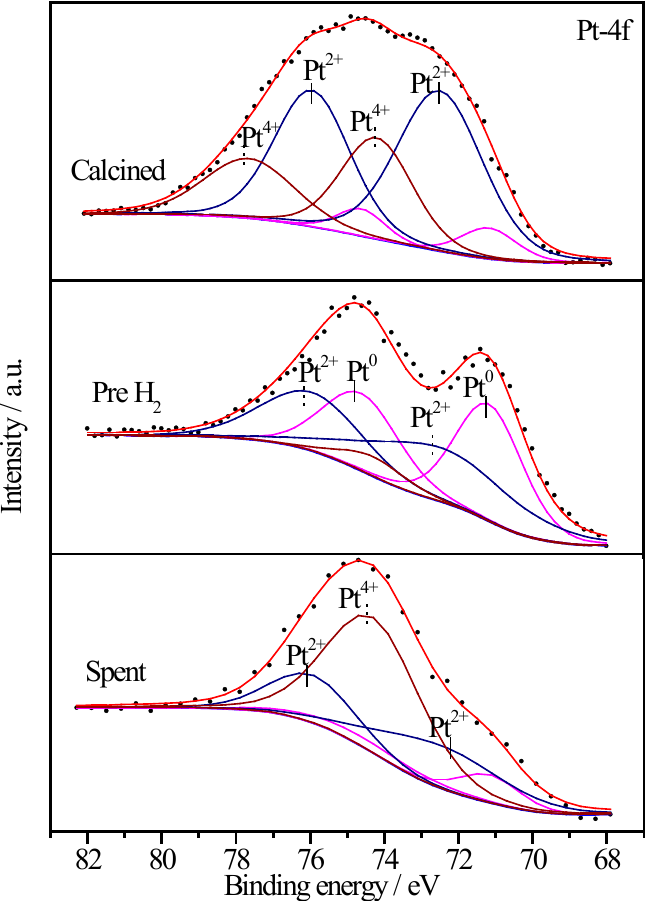
Figure 13. Pt-4f XPS spectra of the calcined, reduced, and spent Pt/CoO x /TiO 2